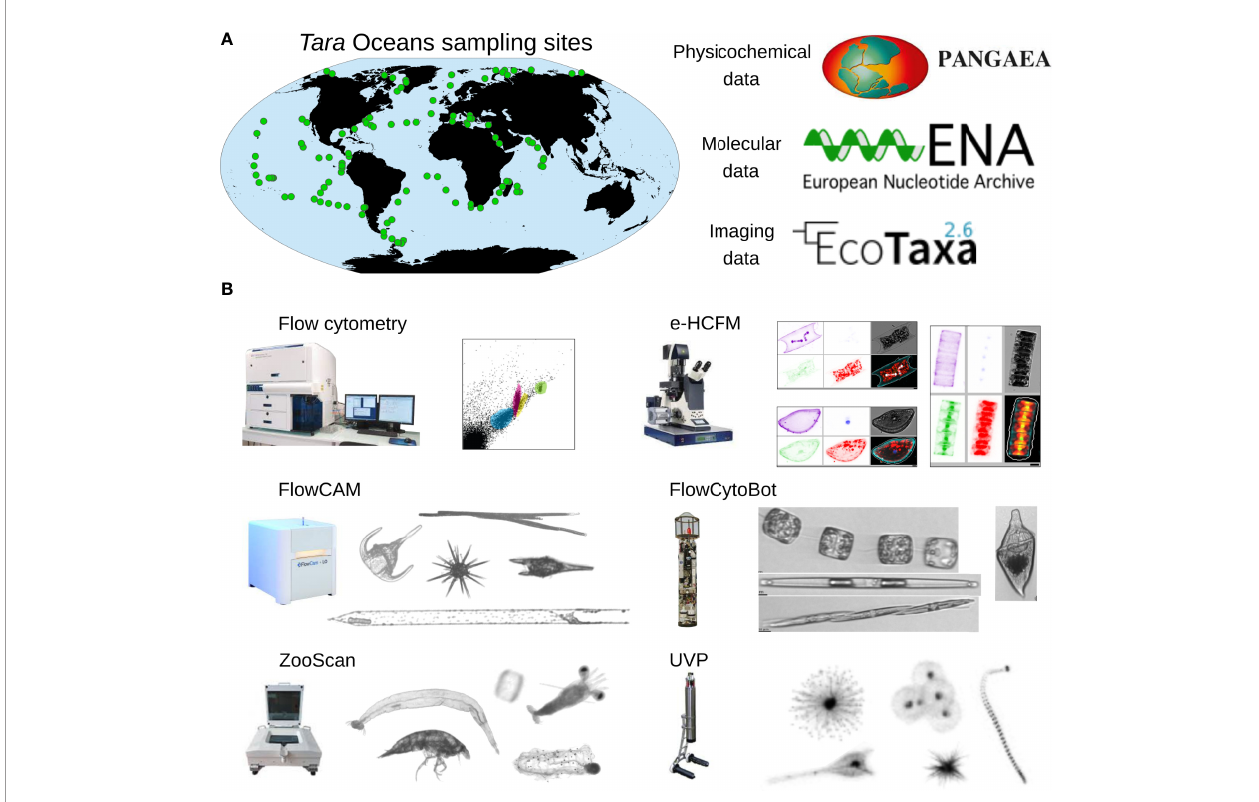
FIGURE 1 | Datasets generated by Tara Oceans expeditions and imaging devices. (A) Tara Oceans expeditions (2009-2013) collected >35000 plankton samples from 210 sampling sites of the upper ocean, which were used for generating physicochemical contextual data as well as >60 terabases of DNA and RNA sequences and ~7 million images (Pierella Karlusich et al., 2020b; Sunagawa et al., 2020). The set of physicochemical and oceanographic parameters can be retrieved from Pangaea repository (https://www.pangaea.de/), the molecular data from the European Nucleotide Archive (ENA; https://www.ebi.ac.uk/ena/), and the imaging data from Ecotaxa (https://ecotaxa.obs-vlfr.fr/). (B) High throughput plankton imaging instruments used in the Tara Oceans expeditions. The fl ow cytometer is used to determine counts of picocyanobacteria, heterotrophic bacteria and eukaryotic picophytoplankton (Gasol and Mora ́ n, 2015). The environmental High-Content Fluorescence Microscopy (e-HCFM) method is based on an automated Leica SP8 TCS confocal laser scanning microscope that enables 3D multicolor imaging of cells (Colin et al., 2017). The instrument was developed at the European Molecular Biology Laboratory for the analysis of objects in the size range 2 – 500 µm, and is best suited to study preserved samples. The Imaging FlowCytobot (IFCB; McLane Research Laboratories, Inc., USA; Olson and Sosik, 2007) is designed for the analysis of objects in the size range 10 – 150 µm, and is appropriate to study live small-size protists such as fl agellates, ciliates and diatoms. The FlowCam (Fluid Imaging Inc.; Sieracki et al., 1998) uses a similar imaging principle as the Imaging FlowCytobot. FlowCam works well with organisms between 20 and 300 m m, with FlowCam-nano and FlowCam-macro for smaller and larger organisms, respectively. The ZooScan (Hydroptics, France; Gorsky et al., 2010) is a benchtop scanner instrument useful for the analysis of objects in the size-range 300-5000 µm, and is best suited to study preserved samples of organisms such as large hard-shelled protists (e.g., Rhizaria) and metazoa. The Underwater Vision Pro fi ler (UVP5, Hydroptics, France; Picheral et al., 2010) is designed to detect and count objects of >100 µm in size and to identify those of >600 µm in size. It is appropriate to study fragile aggregates such as marine snow particles and organisms that tend to break when sampled with nets, such as gelatinous